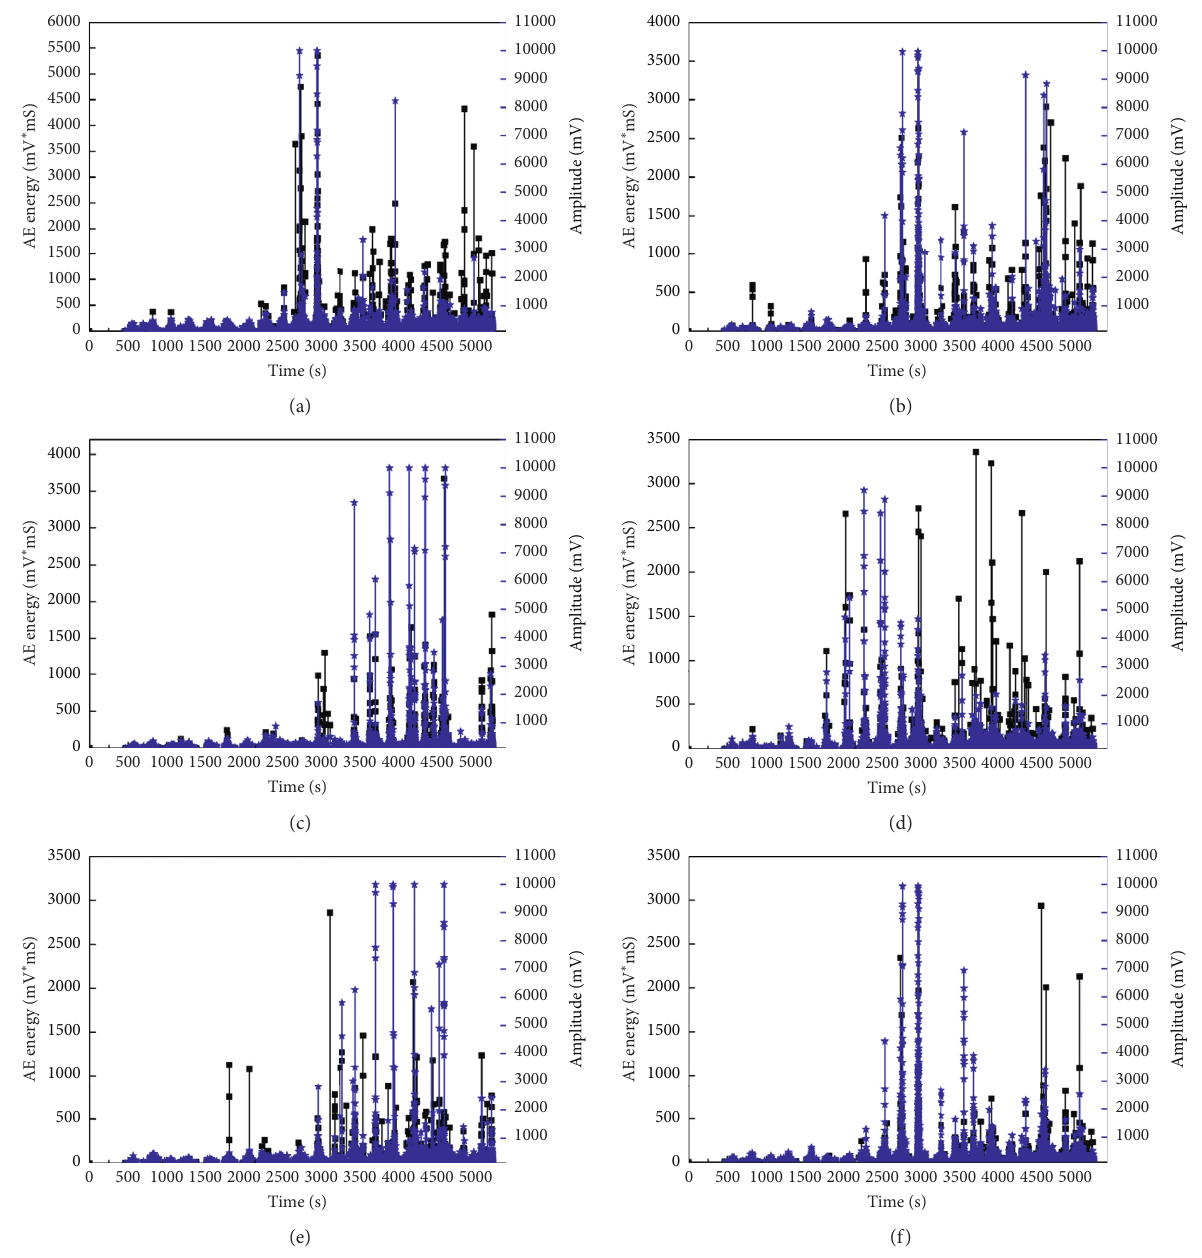
Figure 10: Amplitude energy scatter diagrams. (a) AE sensor 5. (b) AE sensor 6. (c) AE sensor 1. (d) AE sensor 2. (e) AE sensor 8. (f) AE sensor 3.